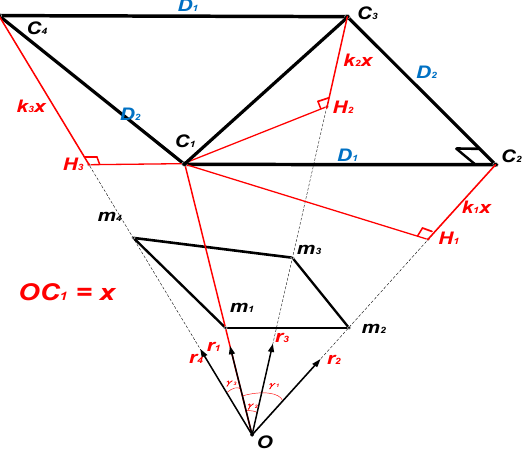
Figure 11. Geometry of the proposed analytic and non-iterative method.